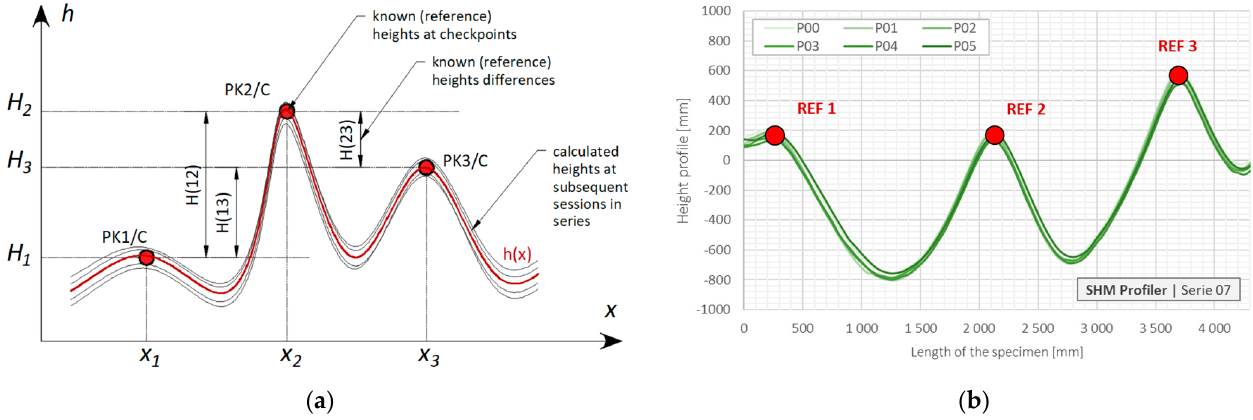
Figure 10. Analysis of sensor’s accuracy: ( a ) theoretical scheme; ( b ) graphical representation of example uncorrected results from one series of measurement sessions with checkpoints marked. Table 2. Relative 1 errors (%) calculated for uncorrected and corrected 2 data in series no.